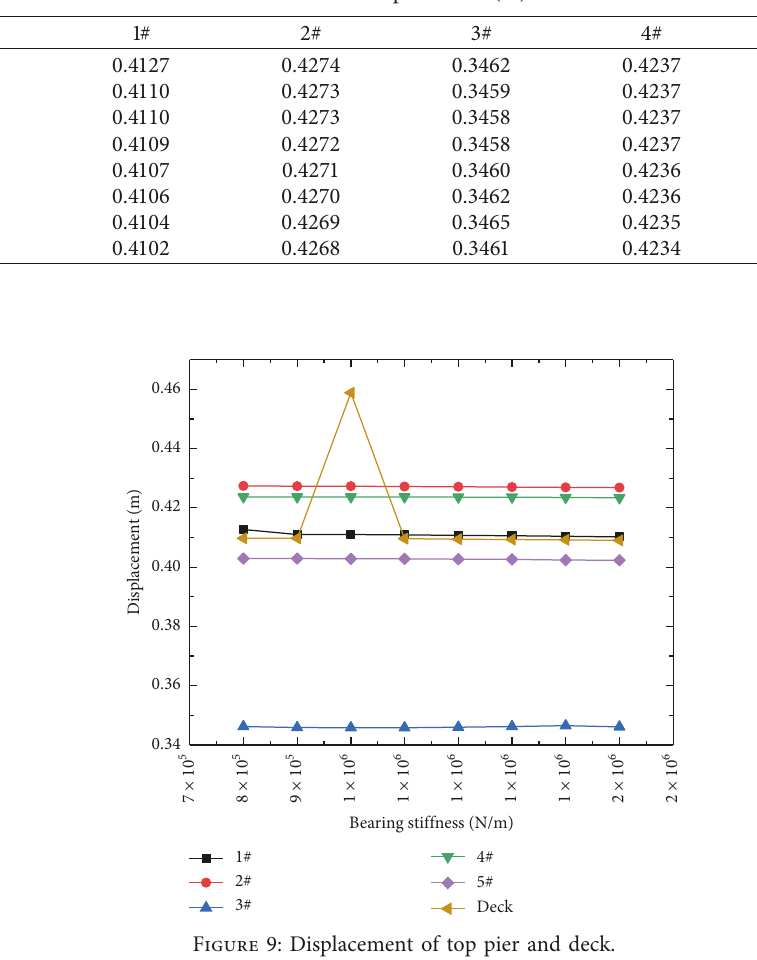
Table 4: Displacement